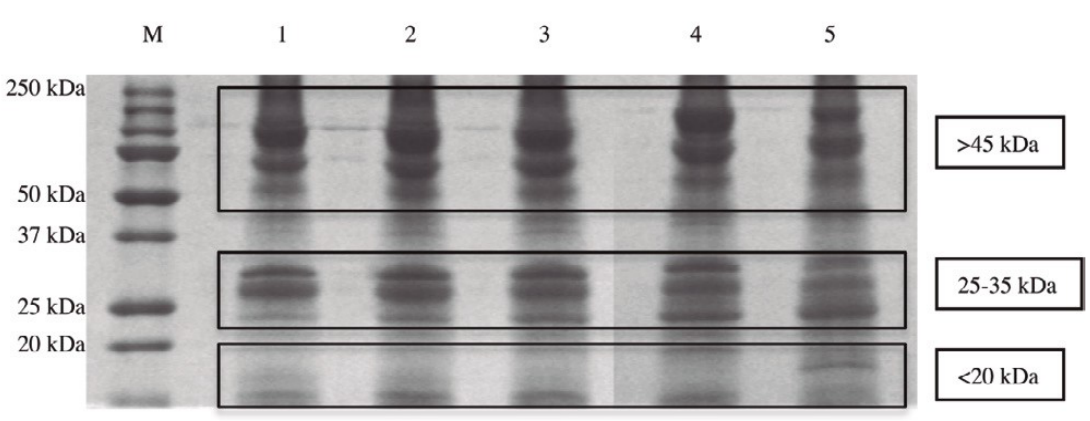
Figure 1. The different composition of proteins taken in the five stages of cell differentiation analyzed on a one-dimensional sodium dodecyl sulphate-polyacrylamide gel electrophoresis (SDS-PAGE).